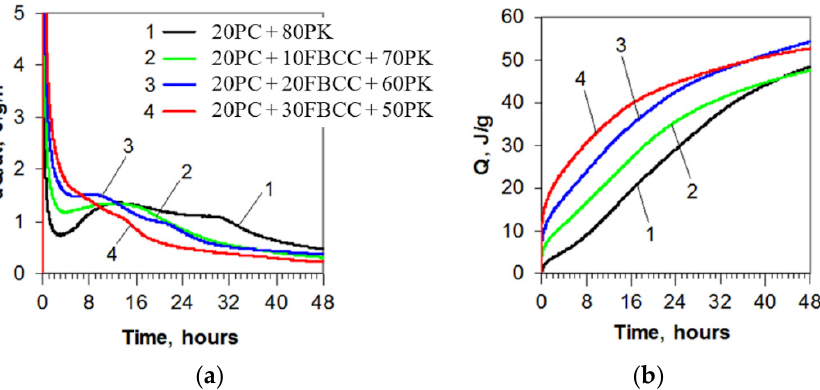
Figure 1. Heat evolution curves ( a ) and total heat released ( b ) for blended four-component binders.